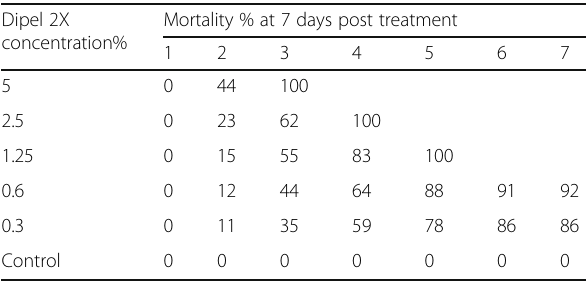
Table 1 Mortality rate of S . recurvalis larvae (L 2 ) fed on diet mixed with different concentrations of Dipel 2X ( B . thuringiensis kurstaki ) in 7 days post treatment Dipel 2X concentration%